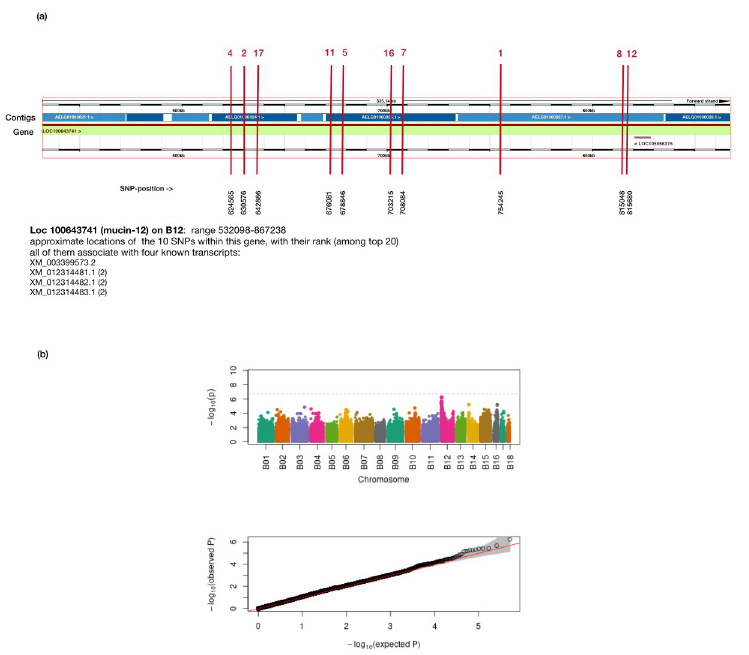
Fig 2. GWAS for the high-coverage study (8 x 8 matrix). (a) Genomic region annotated as mucin-12 (LOC100643471). The vertical red lines indicate the position of SNPs associating with infection intensity. Red numbers above line refer to rank listed in Table 3. All SNPs are intronic and refer to four transcripts: XM_003399573.2, XM_012314481.1, XM_012314481.2, and XM_012314481.3. The region shown here extends from pos. 532,098 to 867,238. The blue band refers to contigs, the green band to the predicted gene, mucin-12 . (b) Manhattan plot for the high-coverage study; data as described in text. Top panel: Probability ( p ) of association with infection intensity for SNPs along the genome (with chromosome B01 to B18 in different colours). No SNP reached the genome-wide threshold (dashed line corresponds to basic cutoff-value of P = 0.1 after Bonferroni correction). Bottom panel: comparing expected to observed probabilities. The calculations used sqrt-transformed infection intensities (case ’lmm_sqrt_res’ above, pruned for LD > 0.75), and using p_lrt as measure.